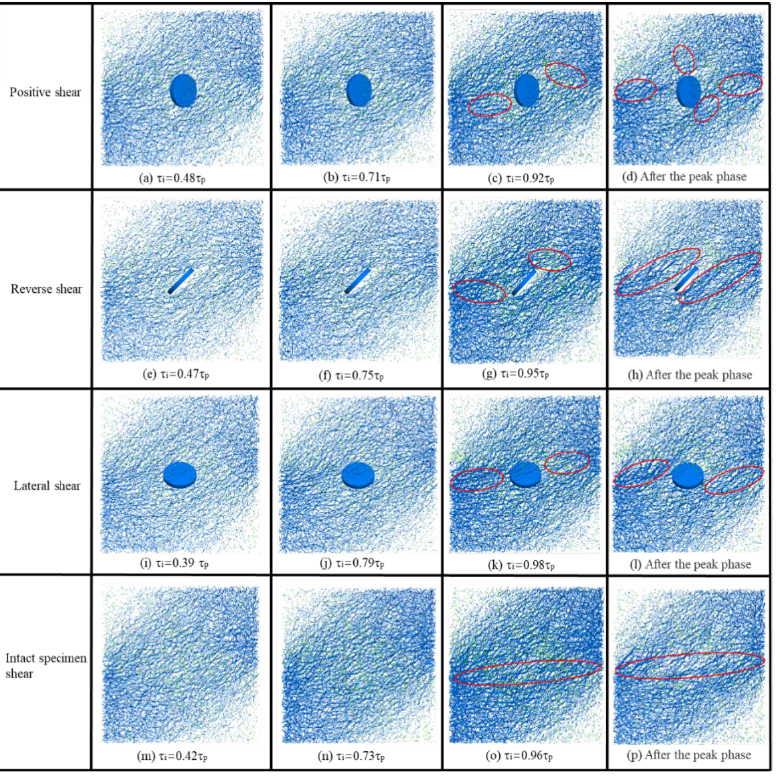
Figure 18. Changes in contact force chain of four groups of model samples at different